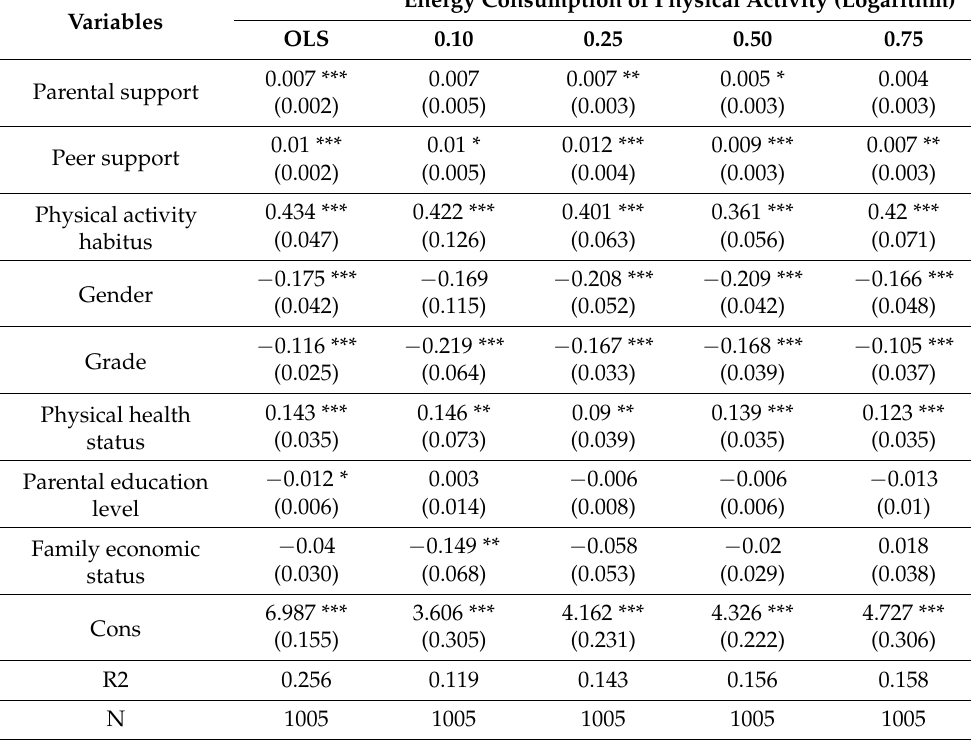
Table 5. Influence of parental and peer support on physical activity energy expenditure (natural logarithm) of college students.